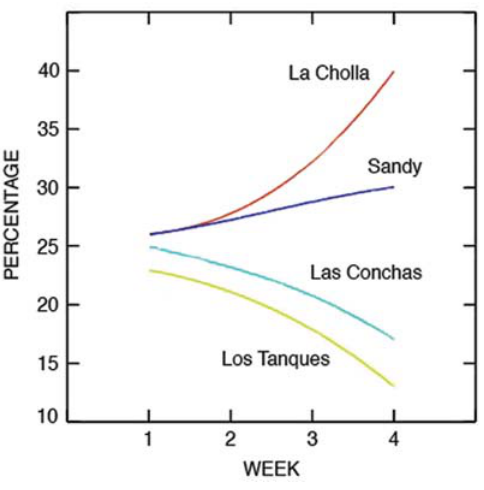
Figure 3. Modeled larval settlement (as relative percentages) within coastal reserves (Las Conchas, Sandy) and fishing areas (Los Tanques, La Cholla) as a function of the day larvae are competent to settle. Model larvae were released every kilometer in the region of interest, from San Jorge Island to La Cholla. Earlier results suggested that there was no source of larvae to the south of the network. No sources were used to the north because models showed that larvae released to the north of the reserve network would be transported away from the network. The model assumed that larvae settled on the day of competency. If that assumption is relaxed, the difference in settlement between northern (Sandy/La Cholla) and southern (Las Conchas/Los Tanques) sites increases.